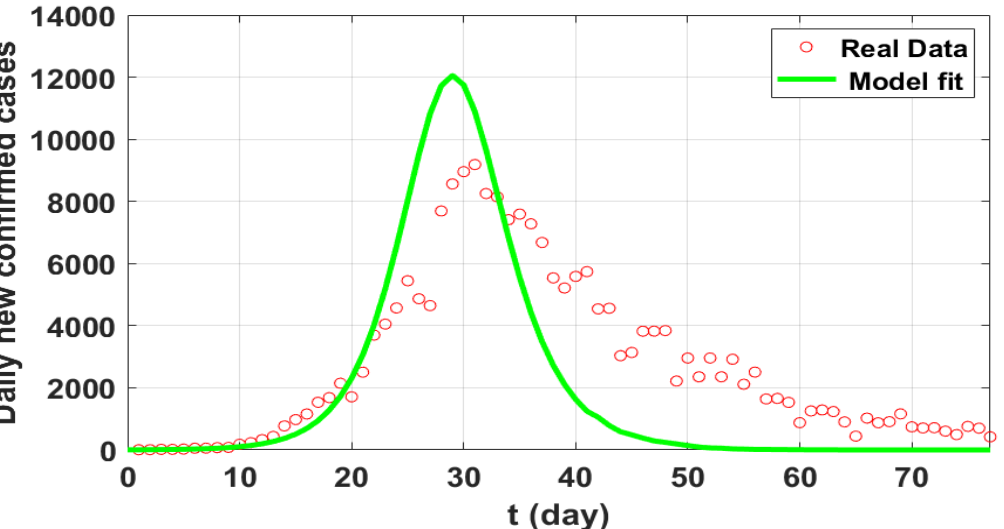
Figure 5. Numerical simulation for system (14–16) at H ∗ = 0.5, α = 1, α 1 = 1, σ 1 = σ 2 = σ 3 = 0.01, σ 4 = σ 5 = σ 6 = σ 7 = σ 8 = 0.1.